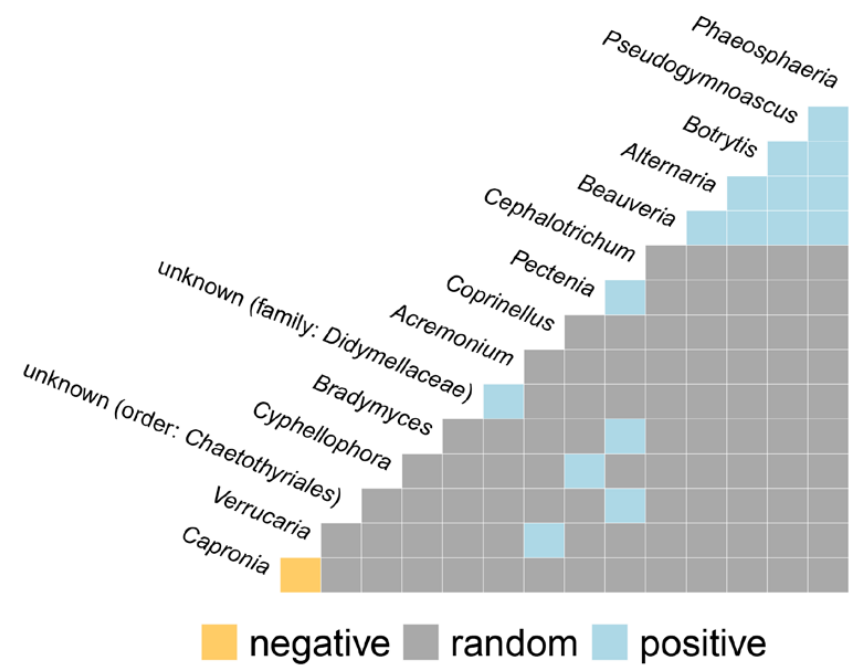
Figure 11. Co-occurrence analysis between detected taxa with positive, negative, and random interactions shown. Only those taxa that were present in any sample with at least 0.5% of occurrence were analyzed.